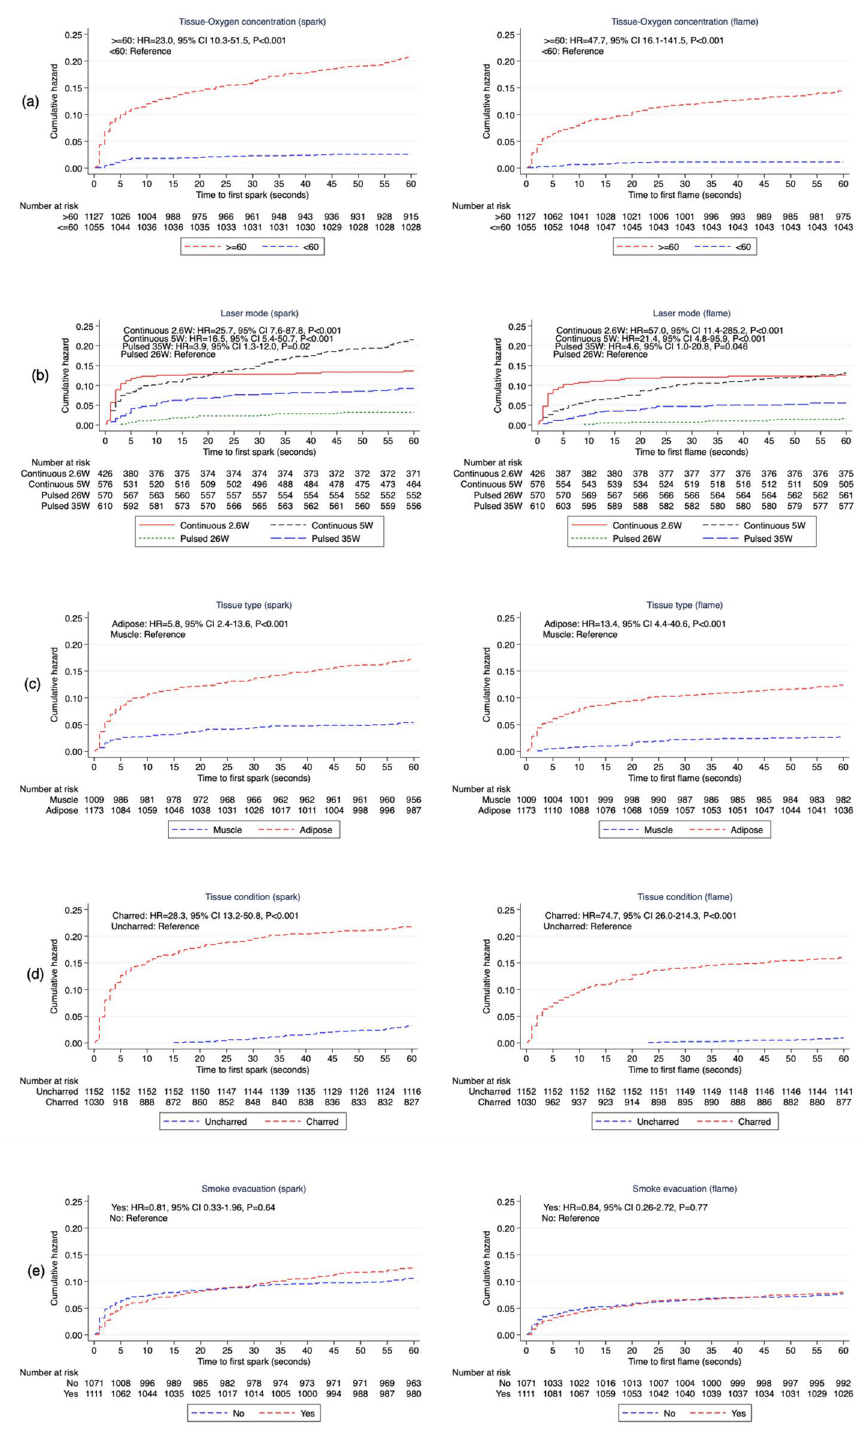
Figure 3. Nelson-Aalen cumulative hazard function of spark and flame by ( a ) oxygen concentration ( b ) laser mode ( c ) tissue type ( d ) tissue condition ( e ) smoke evacuation based on ex-vivo experimental